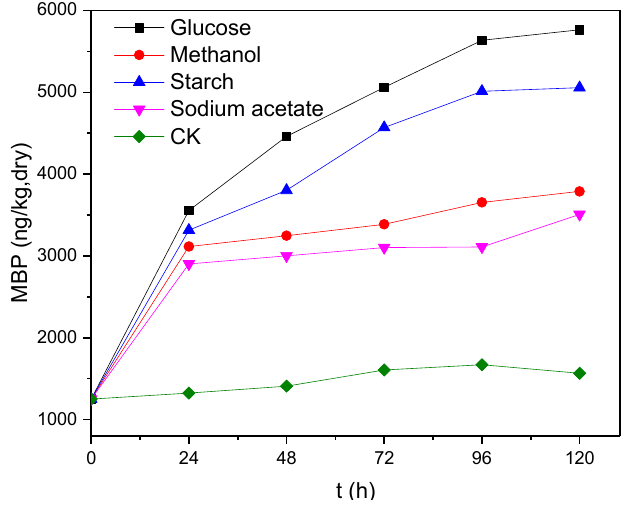
Figure 4. Changes in MBP concentration over time.